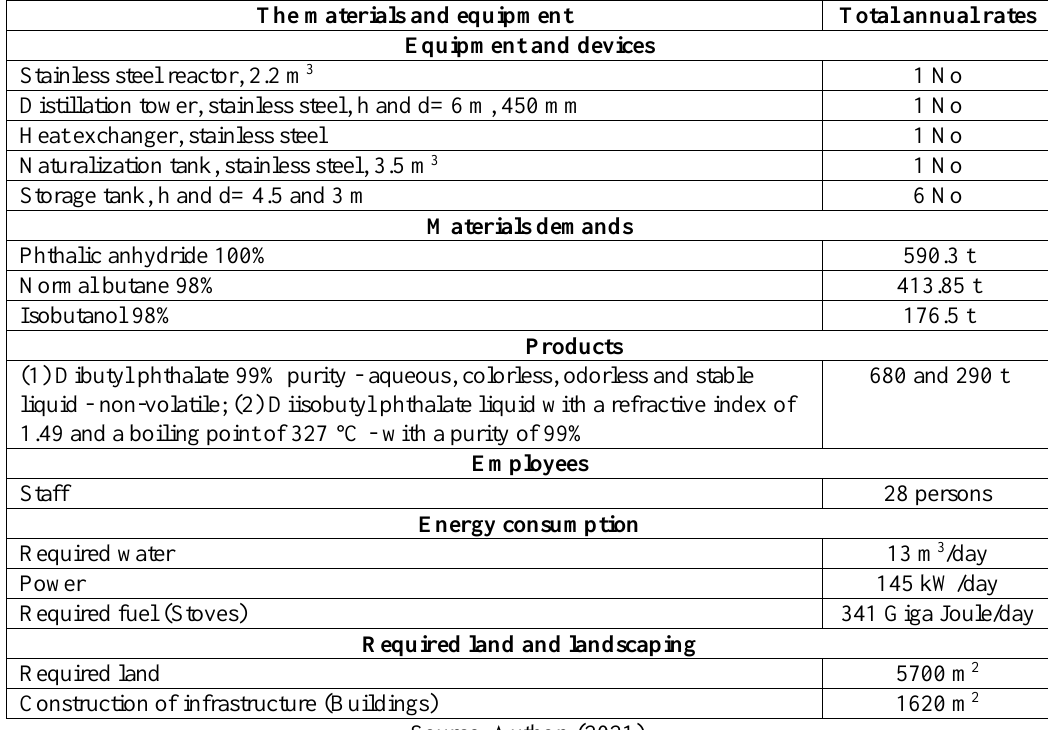
Table 3: The annual requirements of industries of Phthalic anhydrous esters (nominal capacity of 680 and 290t). The materials and equipment